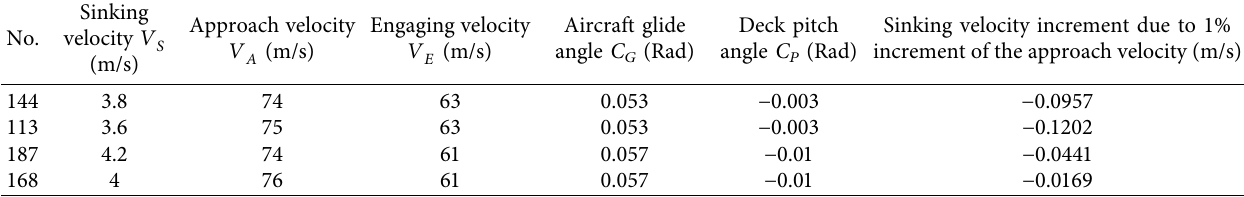
Table 8: The samples demonstrating the phenomenon that when the approach velocity increases, the sinking velocity decreases.